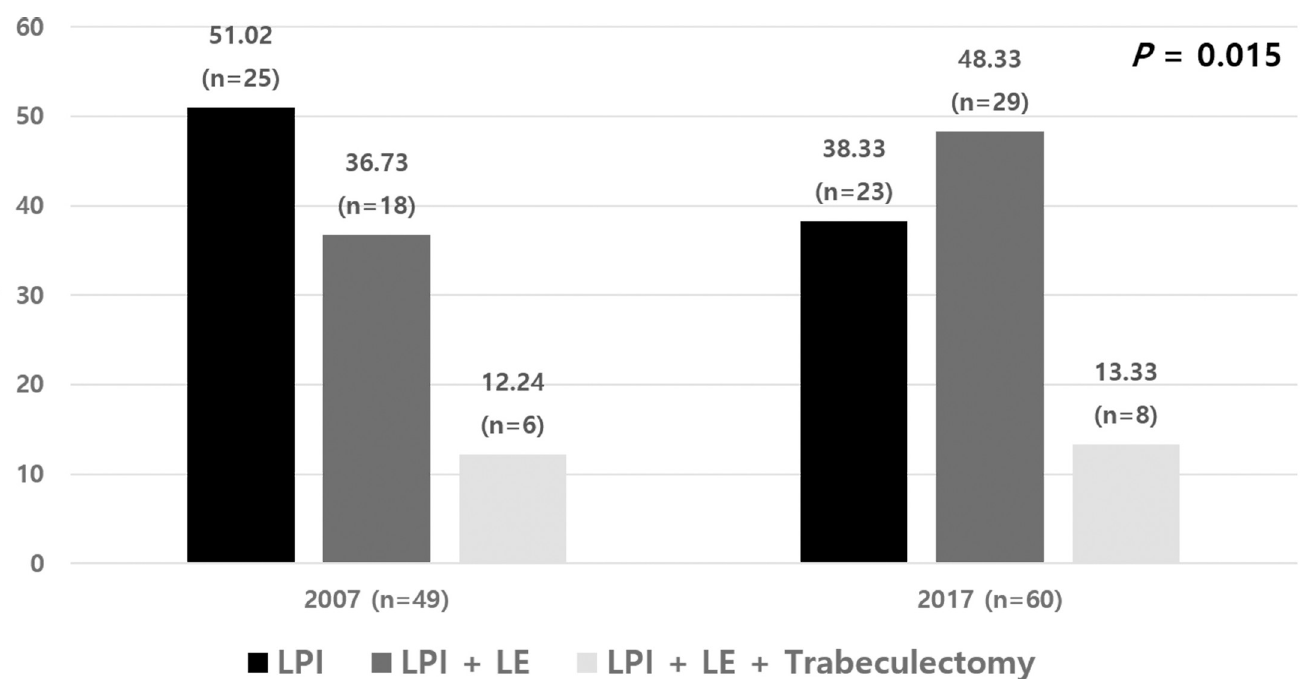
nent subgroup is characterized by greater LV, shallower ACD, and normal iris parameters.